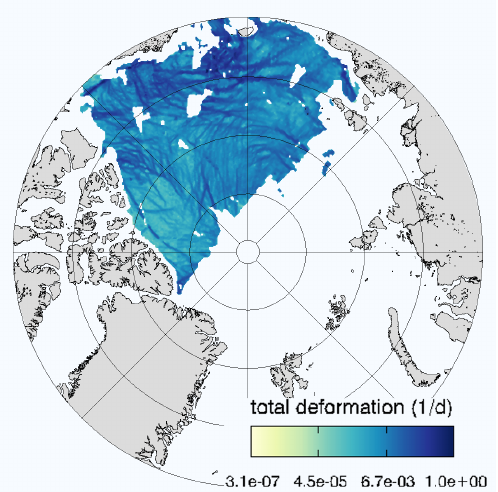
Figure 1. RGPS (Radarsat Geophysical Processor System) example data set (4 January 2006), calculated total deformation.